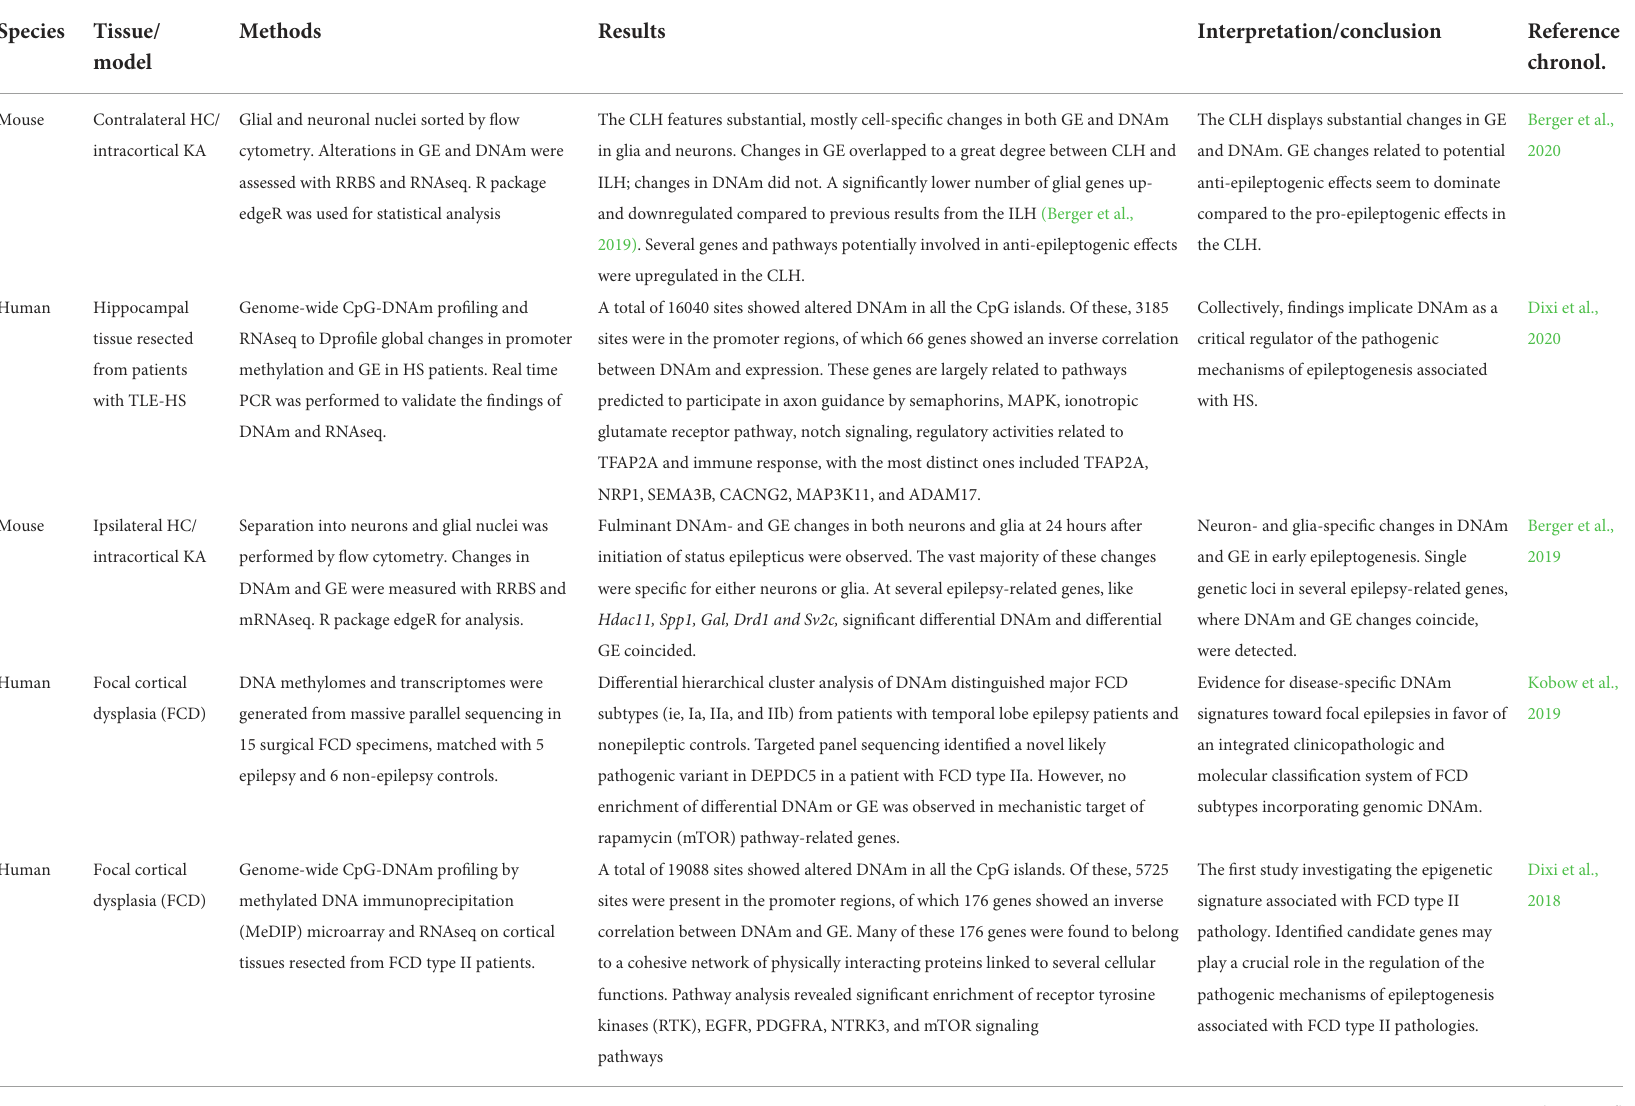
TABLE 1 Relevant studies assessing DNA methylation (DNAm) in